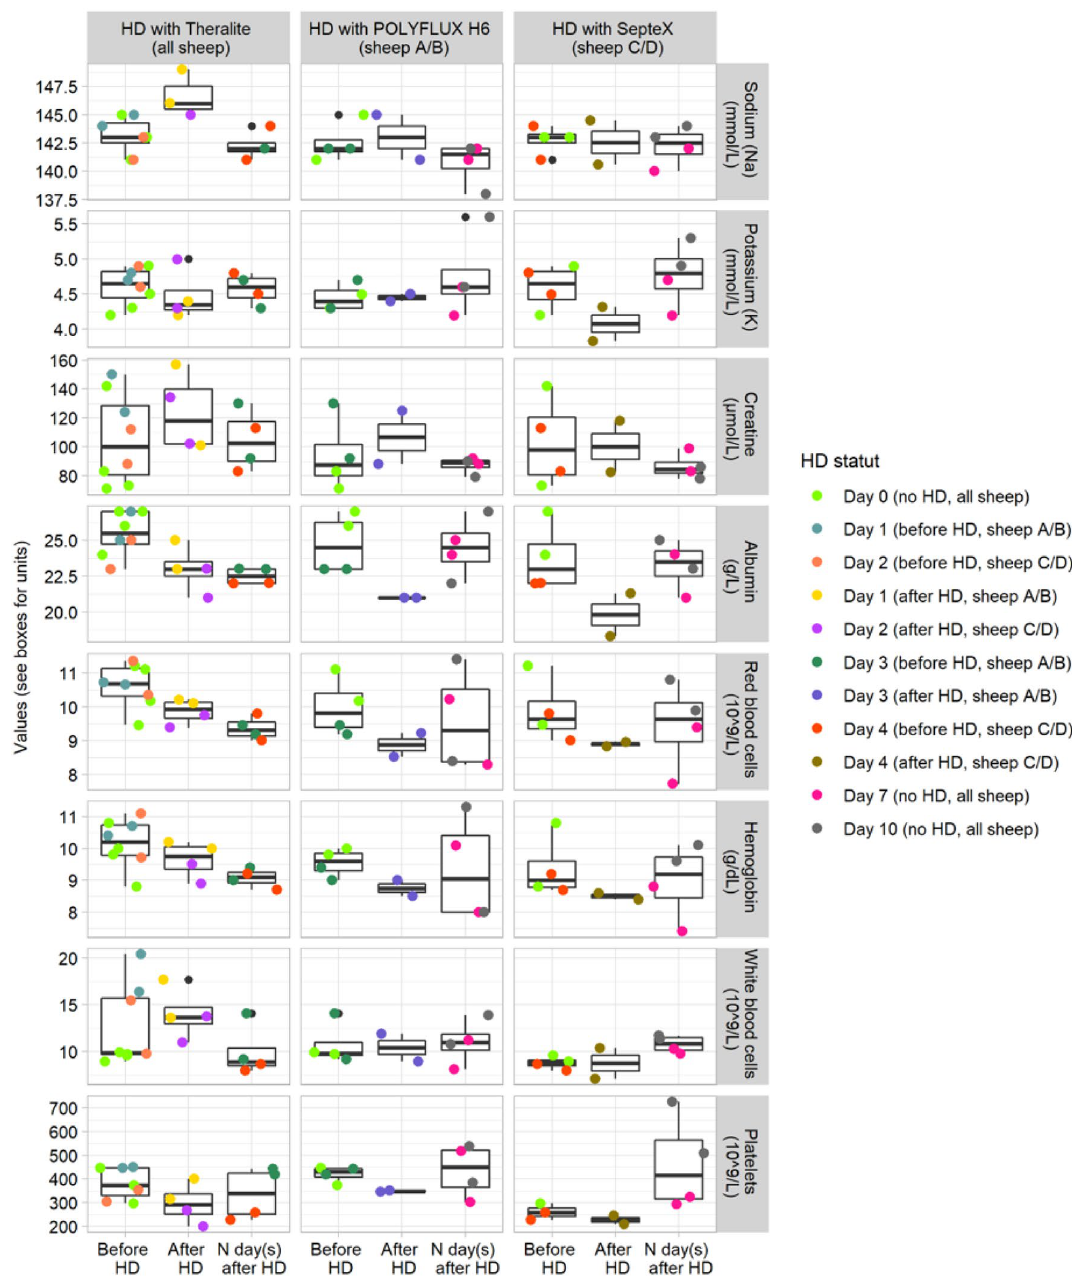
Figure 5. Evolution of a subset of blood parameters according to the experimental and statistical design. Values “before HD” were melted with D0 values to consider the variability within sheep (See column HD with Theralite) or to mitigate the effect of the Theralite HD session in the analysis of both POLYFLUX H6 (sheep A/B, DAY 3) and SepteX (sheep C/D, DAY 4) HD sessions. Note that “before HD” samples of both POLYFLUX H6 and SepteX HD sessions were taken after HD with Theralite and one full resting day for all sheep. Values “after HD” correspond, for all membranes, to the sampling realised at the end of each corresponding HD session. Values “N day(s) after HD” correspond, for the Theralite membrane, to the “before HD” samples of both POLYFLUX H6 and SepteX HD sessions (one full resting day); and to the “DAY 7” and “DAY 10” samples for both POLYFLUX H6 and SepteX membranes (4 to 7 full resting day). The existence of a significant change in abundance with samples categories (before HD, after HD, N day(s) after HD) was tested with a non-parametric Kruskal–Wallis tests. Only the sodium, the albumin and the red blood cells were significantly different for the HD with Theralite membrane ( p value <